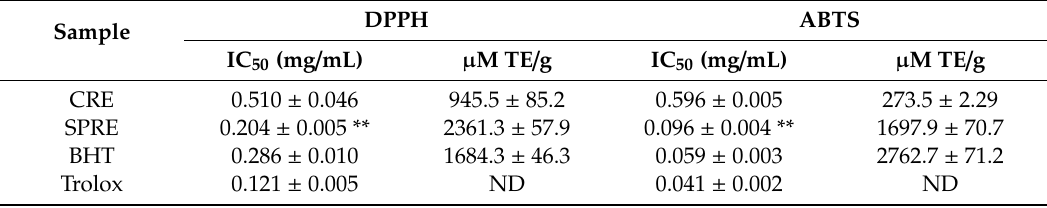
Table 2. IC 50 Values of the crude R. prinoides extracts (CRE) and the semi-purified R. prinoides extracts (SPRE) of R. prinoides on the 2,2-diphenyl-1-picrylhydrazyl (DPPH) and 2,2 (cid:48) -Azinobis- (3-ethylbenzthiazoline-6-sulfonic acid) (ABTS) free radicals. DPPH ABTS Sample IC 50 (mg / mL) µ M TE / g IC 50 (mg / mL) µ M TE / g CRE 0.510 ± 0.046 945.5 ± 85.2 0.596 ± 0.005 273.5 ± 2.29 SPRE 0.204 ± 0.005 ** 2361.3 ± 57.9 0.096 ± 0.004 ** 1697.9 ± 70.7 BHT 0.286 ± 0.010 1684.3 ± 46.3 0.059 ± 0.003 2762.7 ± 71.2 Trolox 0.121 ± 0.005 ND 0.041 ± 0.002 ND Results are expressed as the Mean ± SD (n =